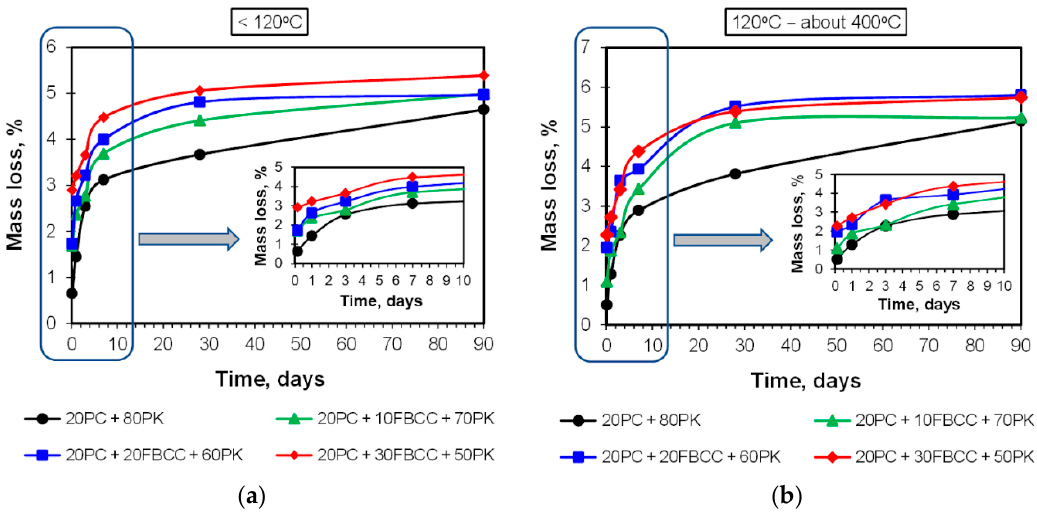
Figure 7. Mass loss at temperature range from 20 to 120 °C ( a ) and from 120 °C to the beginning of mass loss resulting from dehydroxylation of Ca(OH) 2 ( b ).